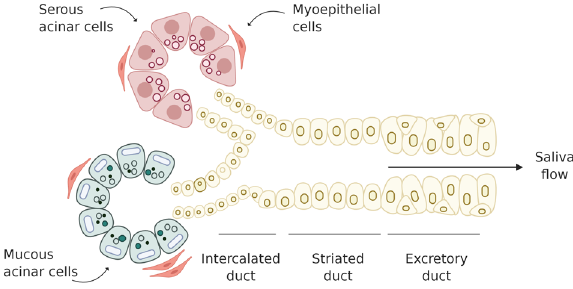
Fig. 1 Schematic representation of a generic salivary gland structure. The salivary gland epithelium is composed of two types of saliva-producing cell types, serous acinar cells and mucous acinar cells. Myoepithelial cells surrounding the acinar unit aids the expulsion of saliva from acinar cells into the ductal network, composed of intercalated, striated, and excretory ducts, through which saliva is modi fi ed and transported to the oral cavity (Figure created with